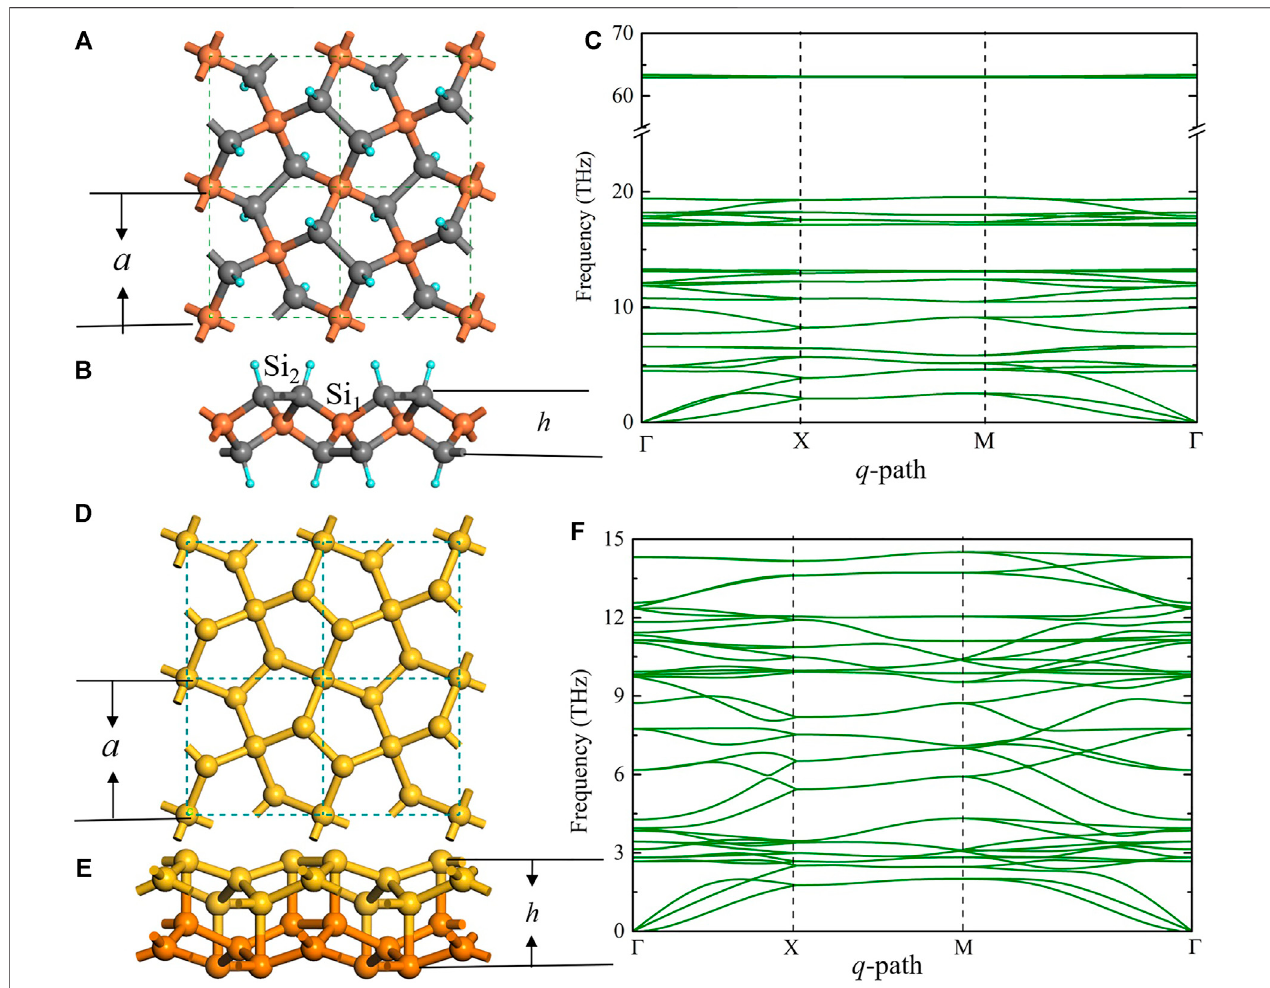
FIGURE 1 | (A) Top view of the H-decorated silicene structure (penta-SiH). The smallest dashed square indicates the unit cell of the pentagonal structure. (B) The sideviewofthesame structure,where a isthelatticeconstantand h isthebucklingdistance.Si1(dark yellow)andSi2(dark gray)represent theSiatomwithand without Hatomdecoration,respectively. (C) Phonondispersioncurveandthephonondensityofstate(pDOS)ofpenta-SiH. (D) and (E) Topviewandthesideviewofthebilayer penta-Si structure, respectively, where a is the lattice constant and h is the buckling distance. Yellow and orange atoms represent the different layers of the bilayer structure. (F) Phonon dispersion curve and the pDOS of the bilayer penta-Si structure.